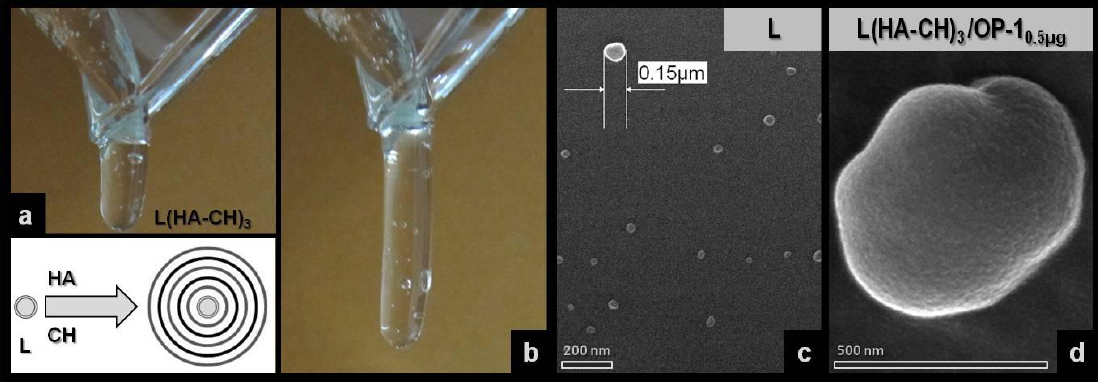
Figure 1. ( a , b ) macroscopic and ( c , d ) SEM views of L and protein loaded L(HA-CH)